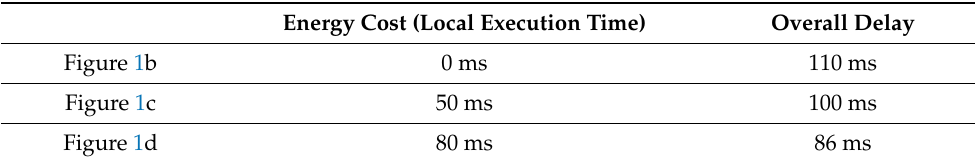
Table 1. The delay